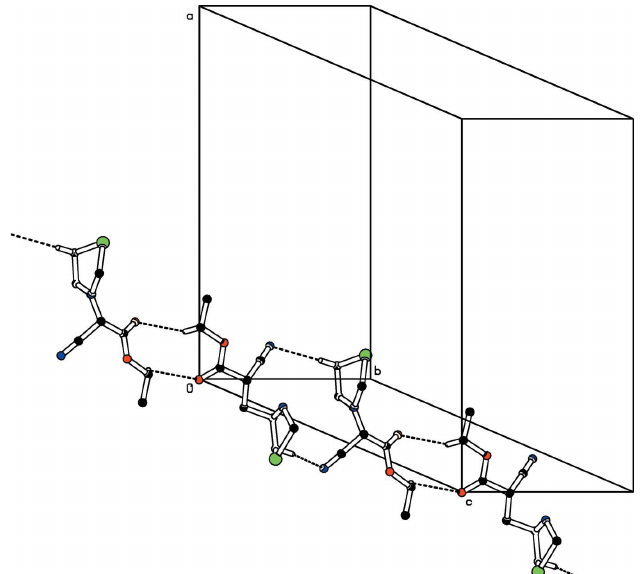
Figure 2 Part of the crystal structure of the title compound, showing the formation of R 2 (10) and R 2 (14) graph-set motifs. Dashed lines indicate hydrogen 2 2 bonds. The fused indeno-quinoxaline rings and H atoms not involved in the hydrogen bonding have been omitted for the sake of clarity.